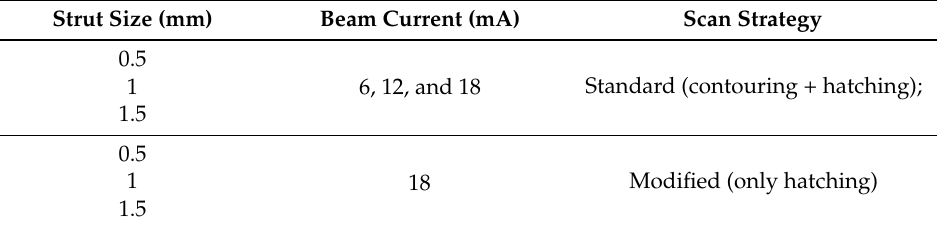
Table 1. EBM settings for fabricating various porous